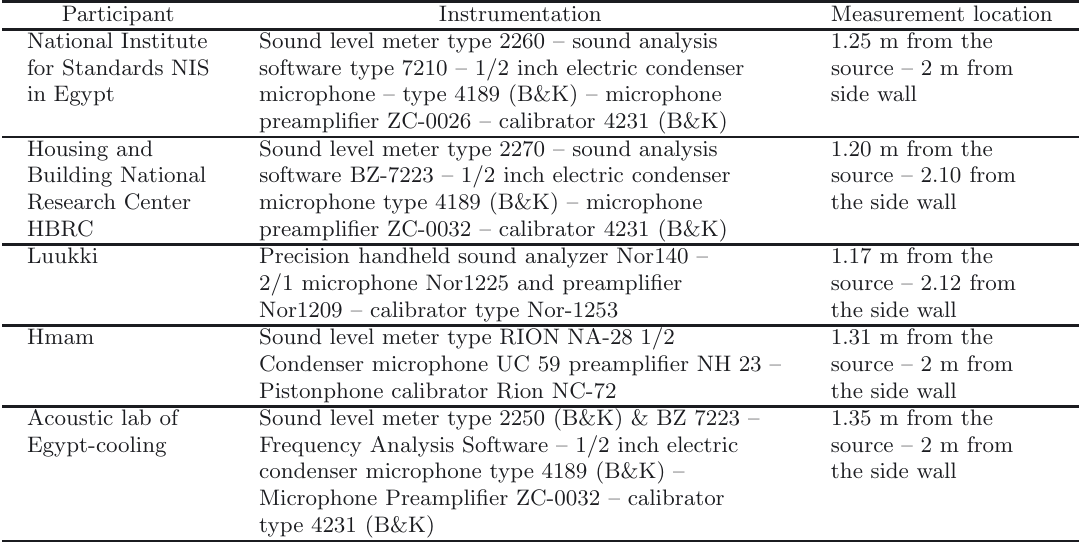
Table 1. Participant laboratories for HBRC acoustic lab proficiency test.